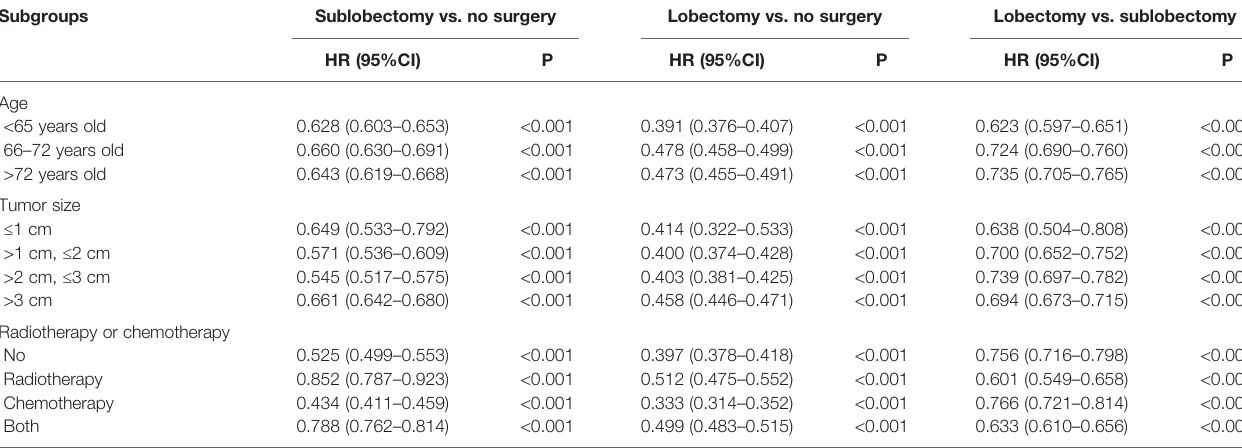
TABLE 5 | Multivariable Cox regression analysis of subgroups of all IIIAN2 stage NSCLC patients after IPTW. Subgroups Sublobectomy vs. no